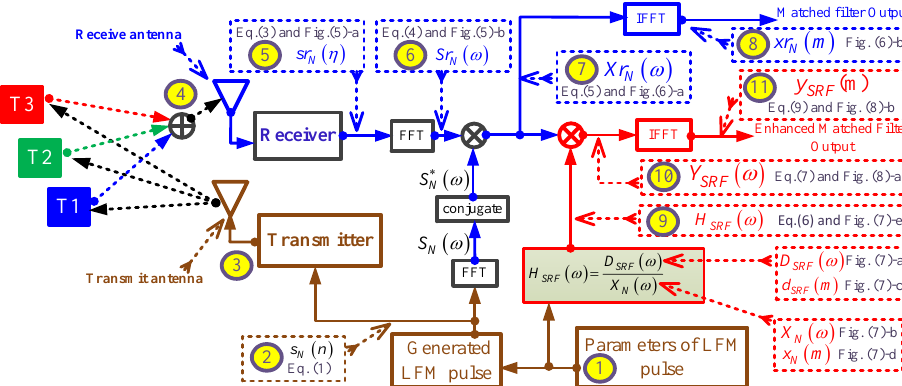
Figure 4. A detailed flowchart of the proposed EMF dealing with three targets.